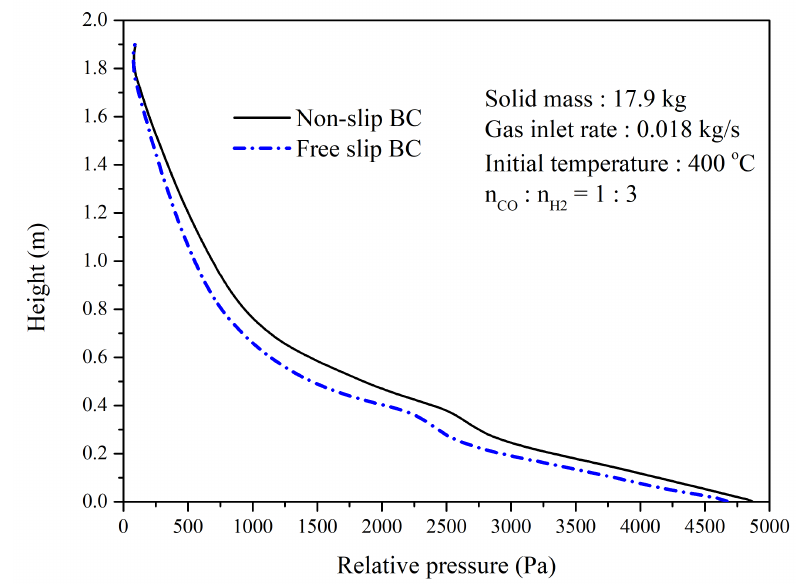
Figure 6. Distribution of time-averaged relative pressure along with